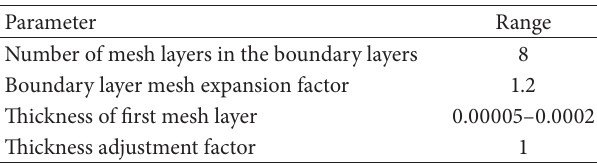
Table 1: The range of free mesh parameters. Parameter